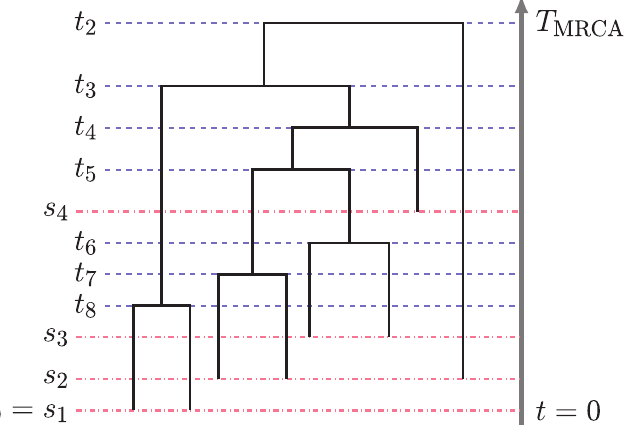
Fig 1. Example of a genealogy with sequential sampling. s 1 , ... , s 4 and t 8 , ... , t 2 indicate sampling times (red dotted lines) and coalescent times (blue dotted lines), respectively. The time increases backwards in time starting with s 1 = t 9 = 0 as the present time. T MRCA indicates the time to the most recent common ancestor at the